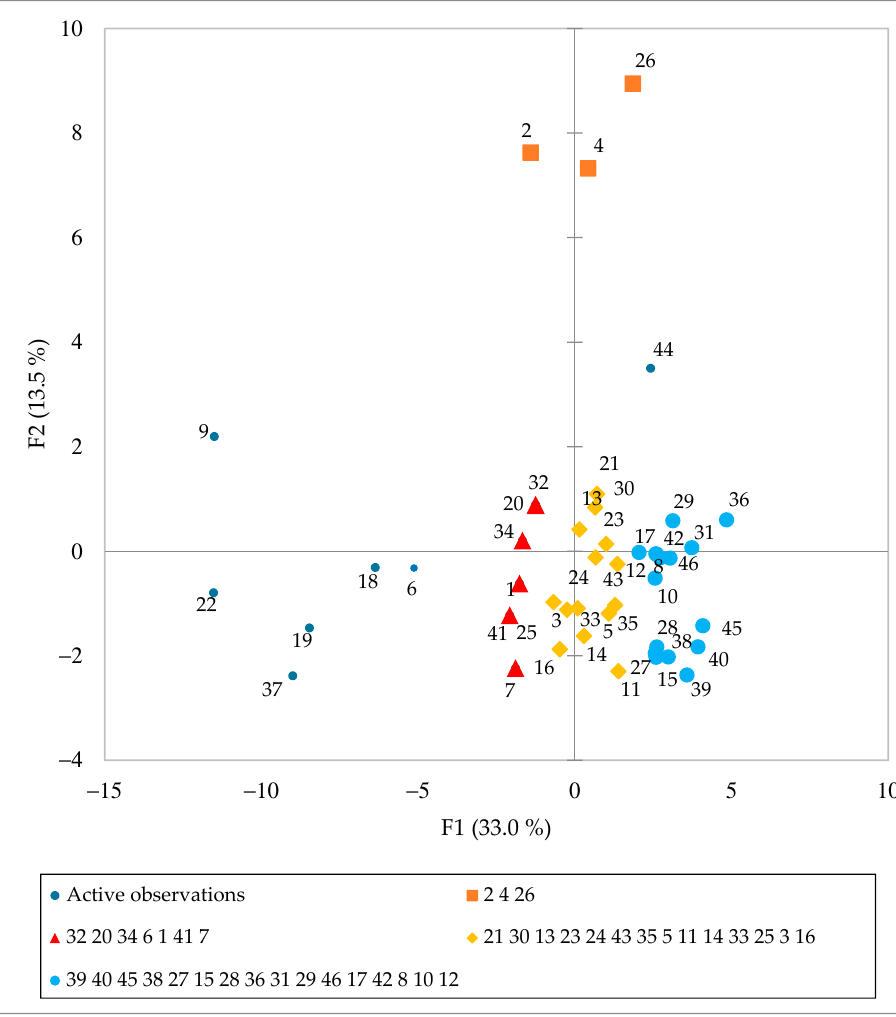
Figure 3. Principal Component Analysis score plot of Spirulina dietary supplements ( n = 47) available in Slovenia.